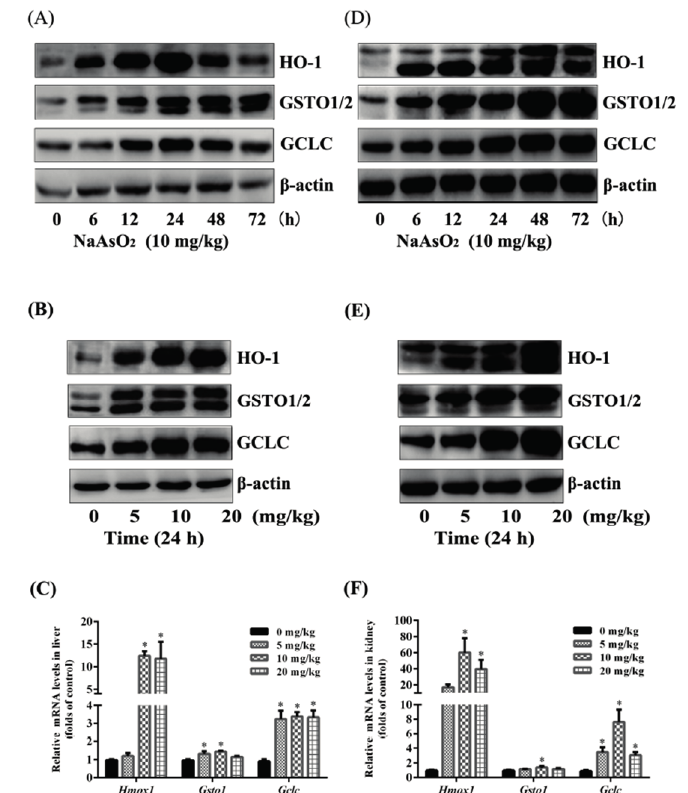
Figure 2. Up-regulation of NRF2 downstream targets both in the liver and kidney of control and acute arsenic-exposed mice. Mice were treated with 0, 5, 10 and 20 mg/kg NaAsO 2 intra- gastrically for the 6, 12, 24, 48 and 72 h, and the extracted proteins of liver and kidney were subjected to SDS-PAGE. Expressions of HO-1, GSTO1/2 and GCLC in the liver ( A, B ) and kidney ( D, E ) of mice were assessed by western blotting. β -Actin was blotted as the loading control. Total RNA of liver and kidney from each 6 h experimental group was isolated and real-time PCR were conducted. The mRNA levels of Hmox1 , Gsto1 and Gclc in liver and kidney were shown as ( C ) and ( F ). Results were expressed as mean ± SD (n = 4), and independent experiments were carried out three times. * denotes p < 0.05 compared with control